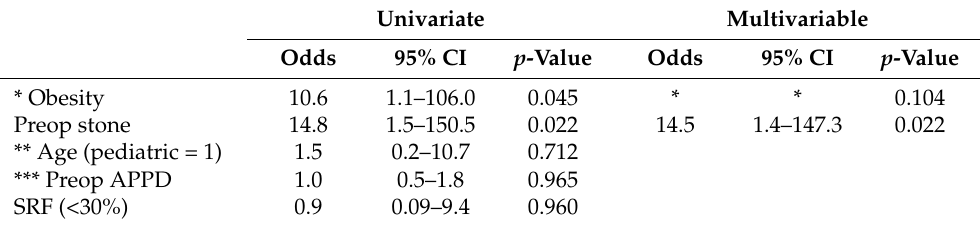
Table 4. Logistic regression analysis of the risk factors for surgical